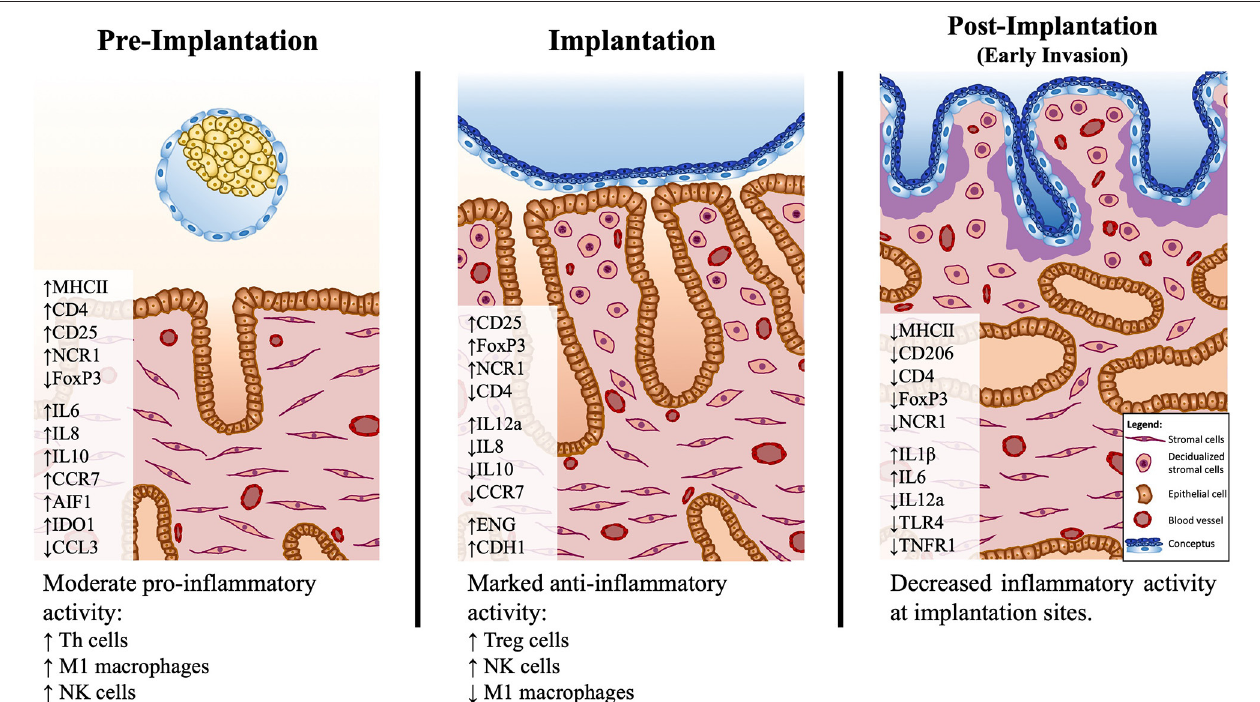
FIGURE 6 | Schematic presentation of the proposed model of immune system–mediated events in the canine uterus during establishment of pregnancy. Arrows ( ↑ and ↓ ) indicate increased or decreased expression, respectively, of different selected factors during establishment of pregnancy: pre-implantation (days 10–12), implantation (day 17 of embryonal life), and post-implantation (day 25 of pregnancy). The presence of the free-floating embryo during pre-implantation is associated with increased inflammatory activity, marked by upregulated expression of markers of M1 macrophages ( MHCII ) and Th lymphocytes ( CD4 , CD25 ). This reaction appears to be moderated by the increased expression of immunomodulatory factors like IDO1 , AIF1 , and IL10 . There is a shift in the immune milieu at the time of implantation, with decreased transcripts of MHCII and increased transcripts of Treg markers ( FoxP3 ). Both pre-implantation and implantation stages show increased expression of the NK cell marker NCR1 . During implantation, concomitantly, the first morphological signs of decidualization are observed in subepithelial endometrial layers. The contribution of the immune system-derived factors to the decidualization process needs further clarification. In the post-implantation period, the expression of several factors investigated is decreased at the implantation sites, indicating a decreased local immune activity in response to embryo